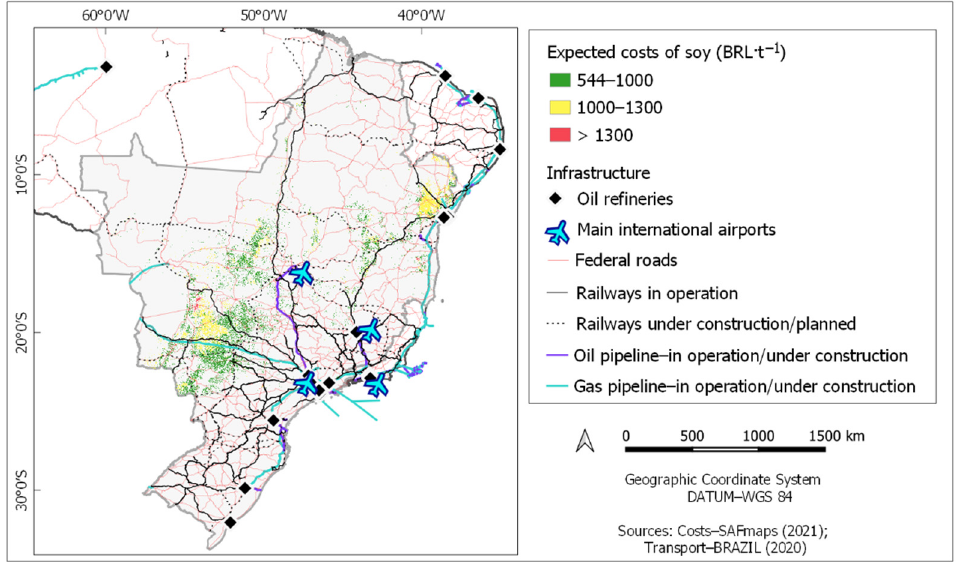
Figure 6. Expected costs of soybean production in available areas for agriculture expansion and required infrastructure for SAF production.